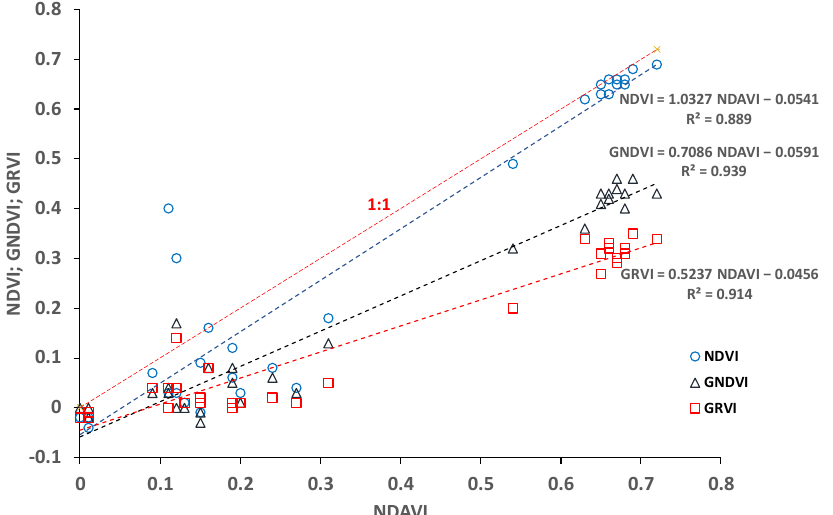
Figure 7. Relationship between NDAVI and each of the vegetation indices NDVI, GNDVI, and GRVI. The data are for three pixel-size sample areas, A1, A2, and A3 (Figure 4a), identified in a section of the Lis River infested with duckweeds, and for the period 6 June to 6 October 2021. The linear regression equations and coefficients of determination are provided. Line 1:1 is shown.